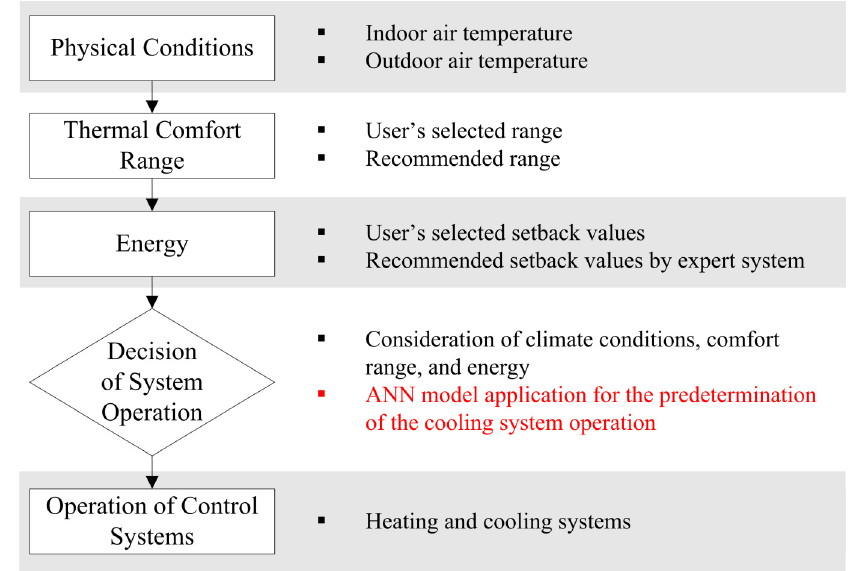
Figure 1. A logic framework for the indoor thermal